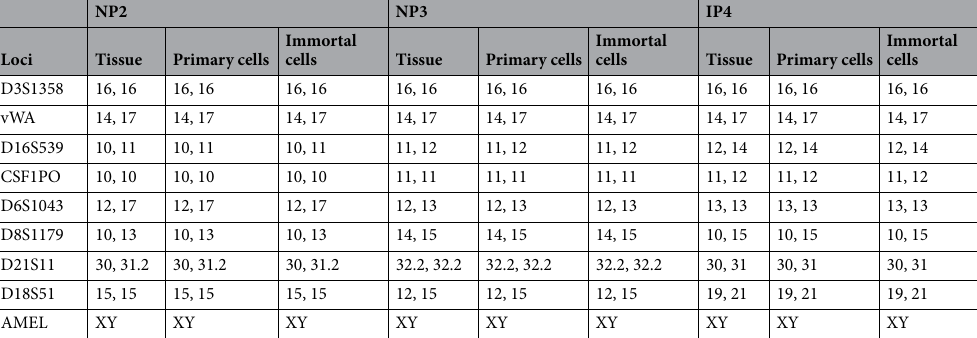
Table 1. STR profiles of primary and primary immortal cells compared to primary